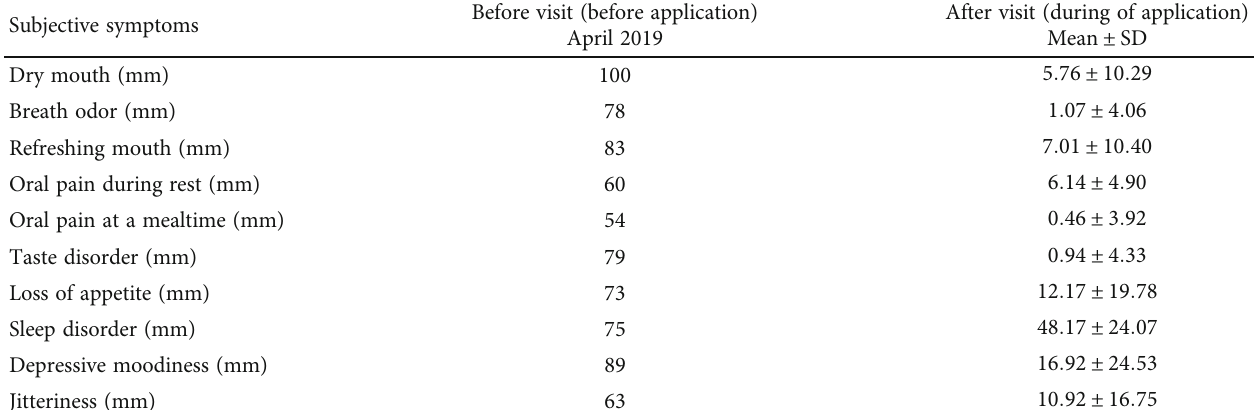
Table 2: VAS score before the dental visit and during REFRECARE-H application.